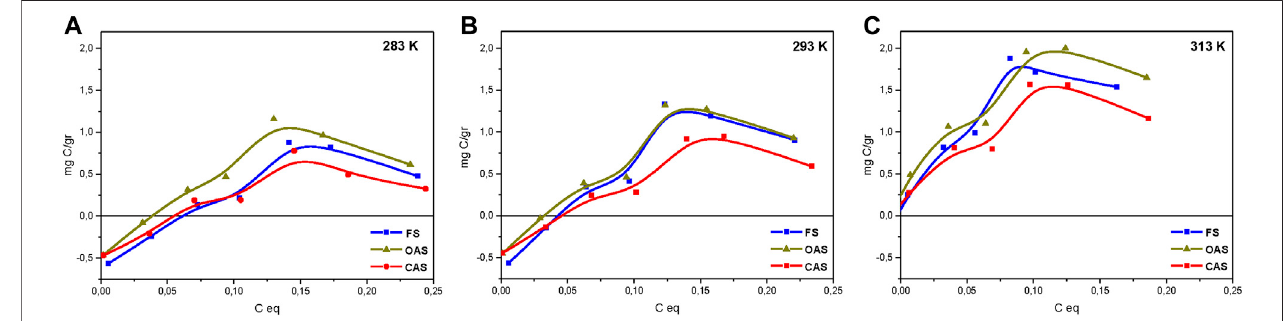
FIGURE7| Absorptionisothermsforstudiedsoils:283 K (A) ,293 K (B) and313 K (C) .FS=forestsample,OAS=organicagriculturesample,CAS=conventional agriculture sample.